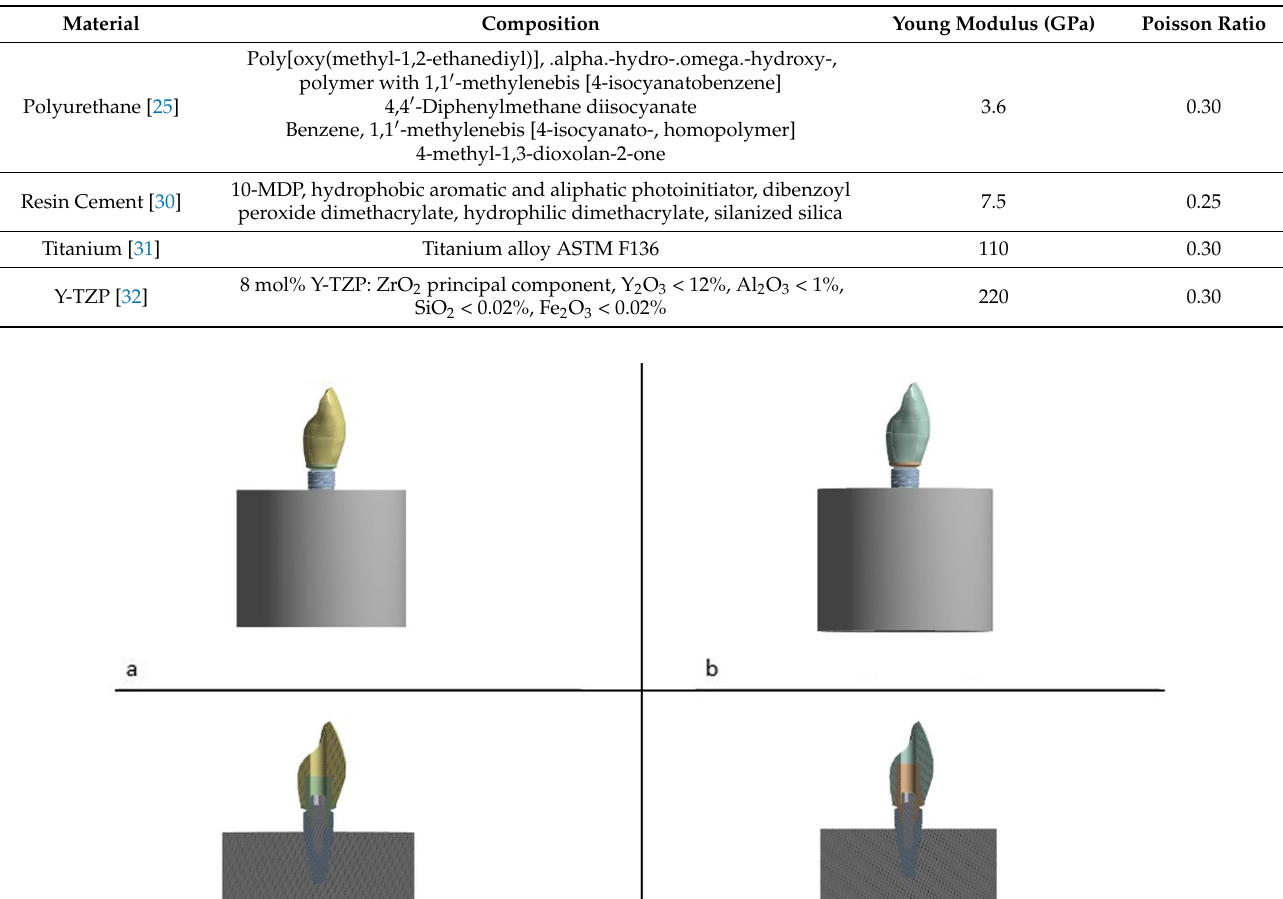
Table 1. Material properties used in the present numerical analysis.